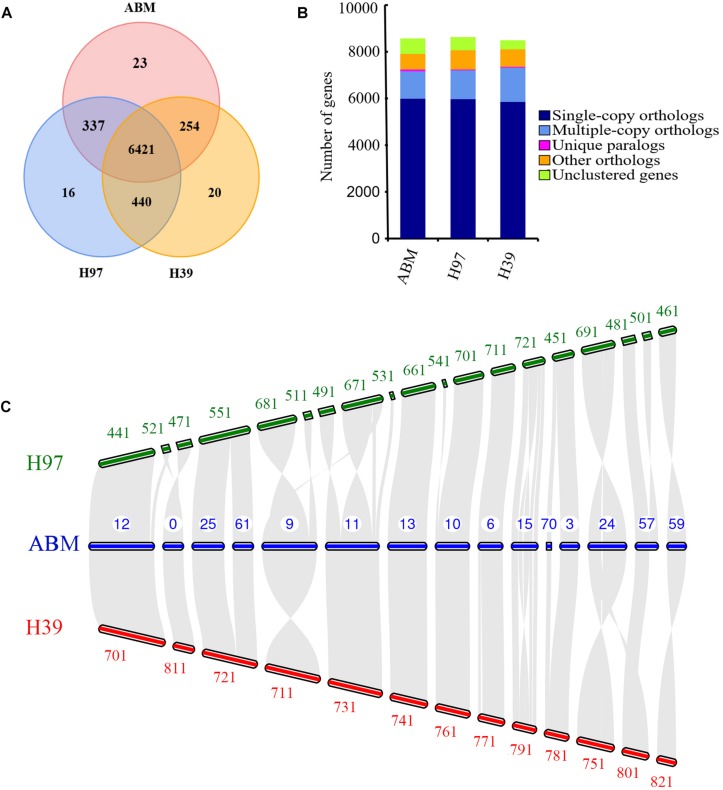
The comparative genomic analysis of three A. bisporus strains. (A) Unique and share gene families. The number of unique and shared gene families is shown in each of the diagram components. (B) Comparison of orthologous genes. (C) Whole-genome collinearity analysis, which only showed the contigs exhibiting significant collinear relationship among species.